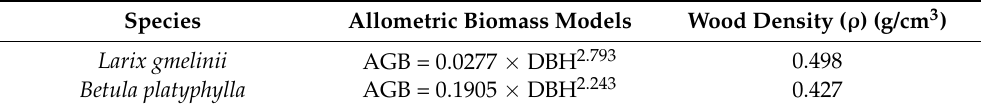
Table 3. Allometric biomass models and basic wood density values for each tree species.